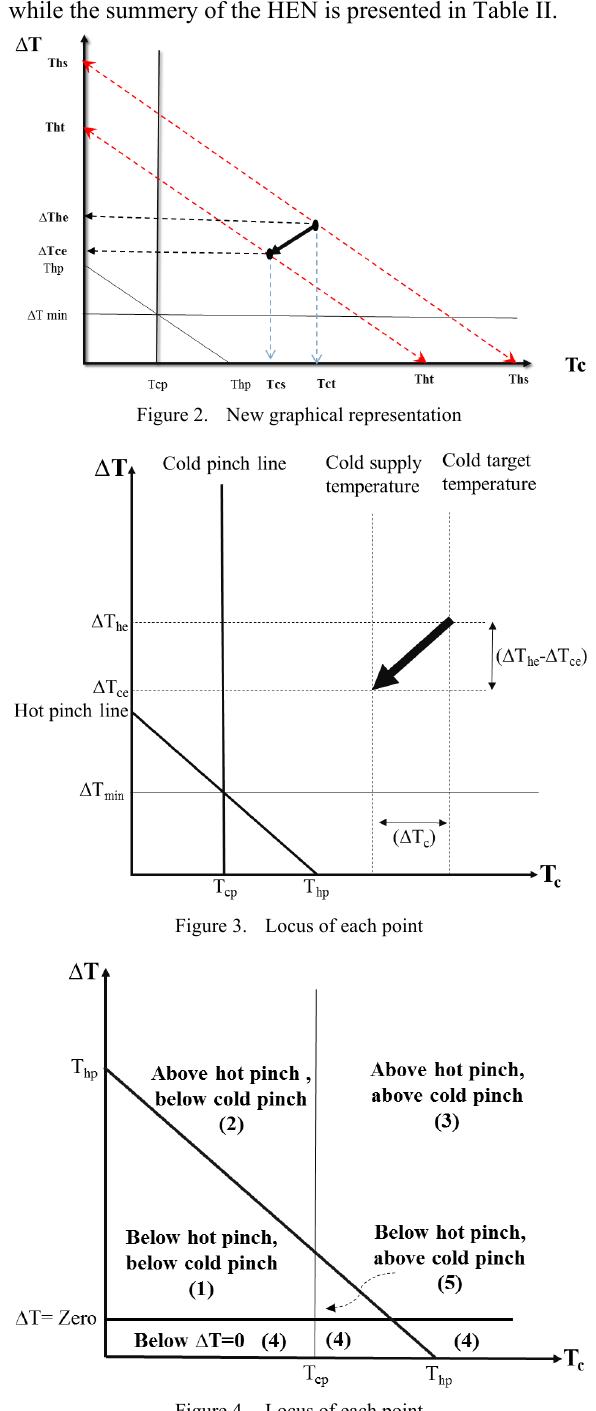
Figure 4. Locus of each